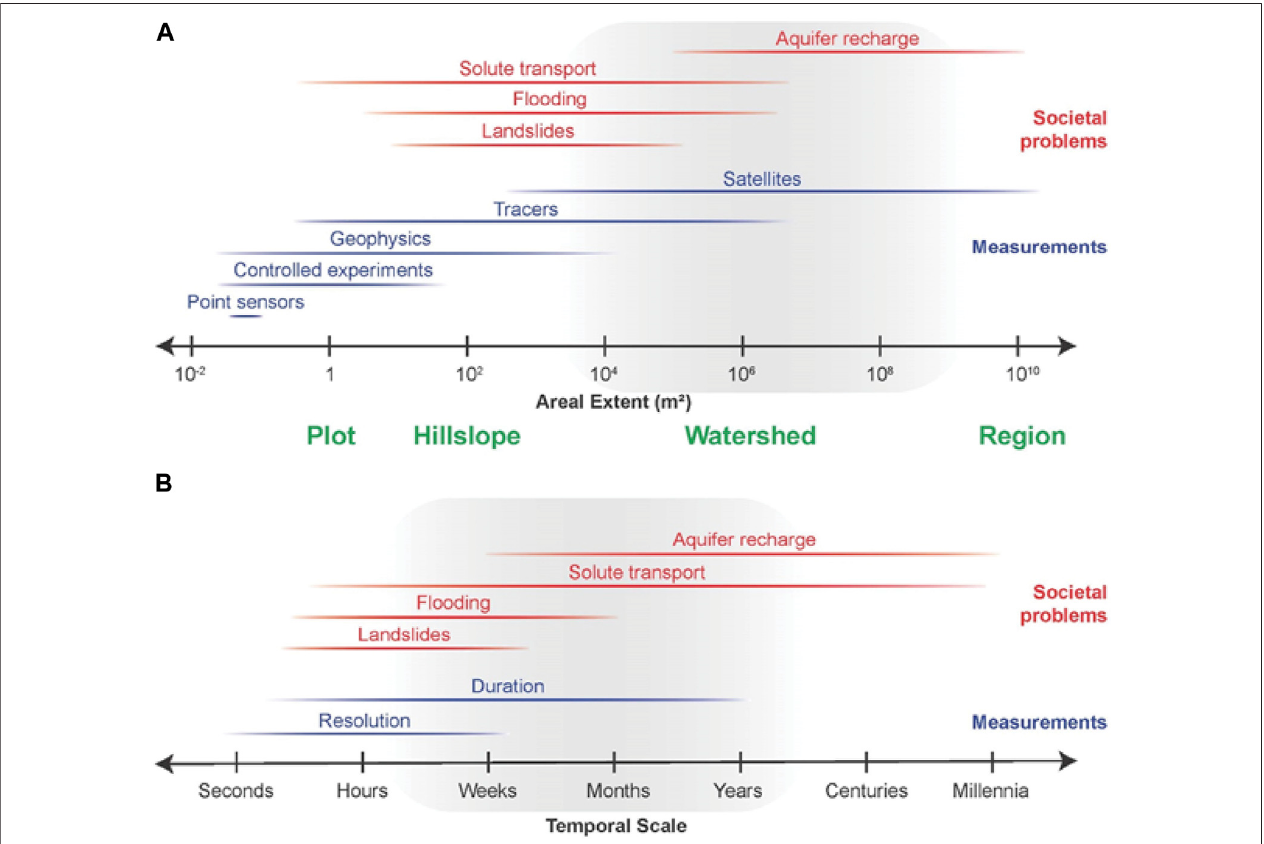
FIGURE 1 | Approximate (A) areal extents and (B) temporal scales of various elements of unsaturated zone science. The gray shaded regions indicate the range of scales that are typically considered important for addressing hazards and water resource decisions. Red lines indicate the typical (A) extents and (B) durationsofvarious problemsofinterest.Bluelines showthetypicalcapabilitiesofvariousmeasurementtechnologies to providedatathatare: (A) representativeof agiven area,and (B) collected overagiven period with agiventemporalresolution.Green textindicatesspatialtermsgenerally associated withcorresponding areal